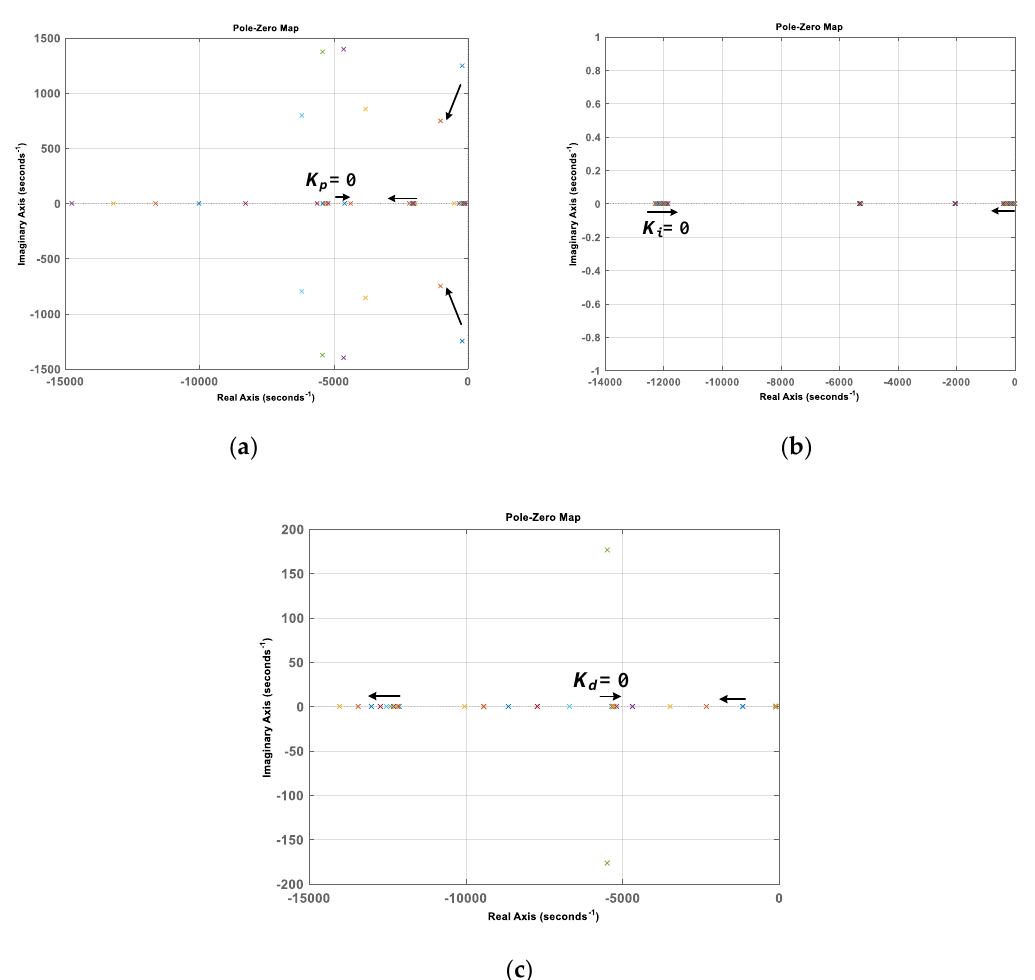
Figure 7. Simulation results of characteristic polynomial. ( a ) The pole-zero map of characteristic polynomial according to k p ; ( b ) pole-zero map of characteristic polynomial according to k i ; ( c ) pole-zero map of characteristic polynomial according to k dp .